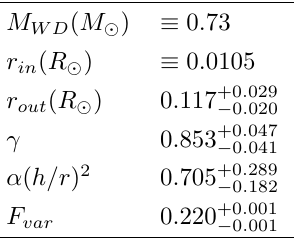
Table 1: Best-fit parameters with associated (1 σ ) er- rors for the fluctuating accretion disk model applied to the Kepler lightcurve of MV Lyrae (Scaringi